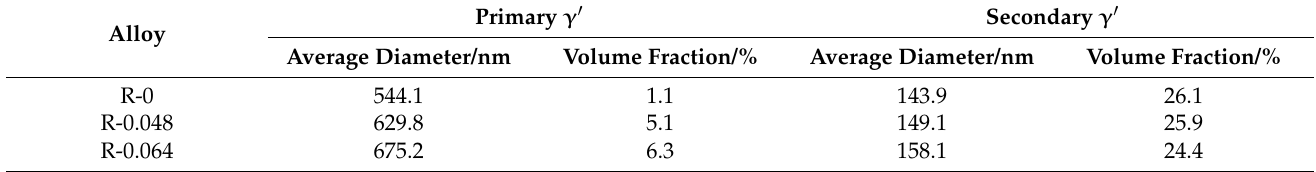
Table 5. The size and volume fraction of primary and secondary γ′ in Sc-doped RR1000.